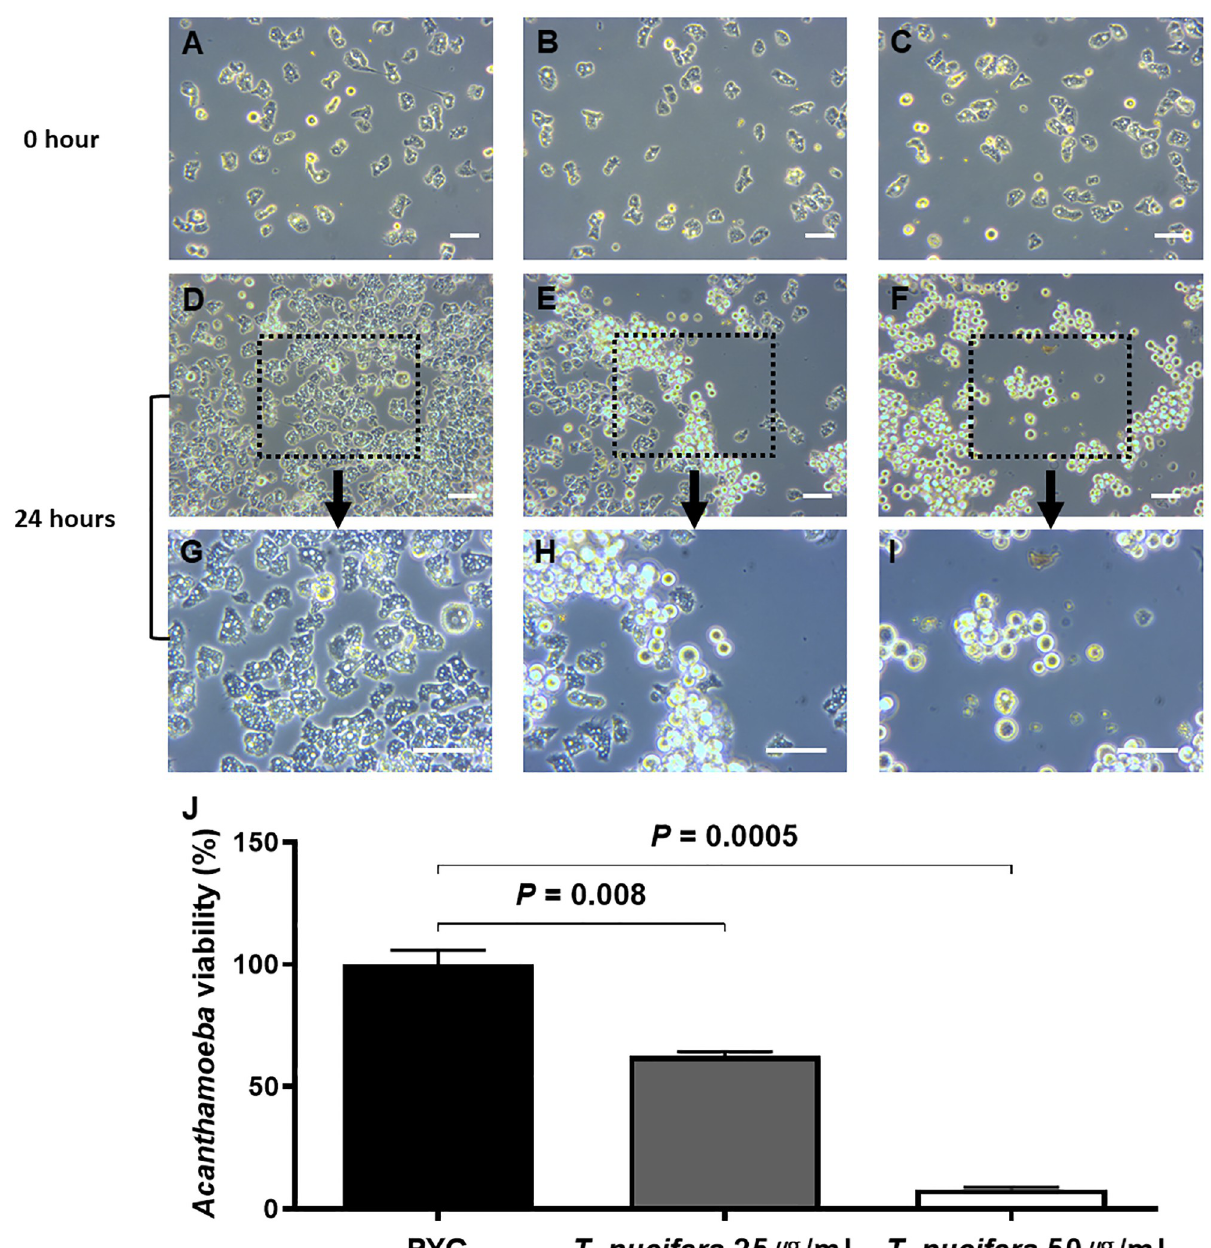
Fig 1. Morphological changes and cell viability in A . lugdunensis after 24 hours of treatment with Torreya nucifera . Compared with the control group (A, D, G), groups treated with 25 μ g/mL (B, E, H) and 50 μ g/mL (C, F, I) of T . nucifera showed morphological changes in which encystation from trophozoites to cysts and shrunken and unviable cells were observed. Cell viability was significantly decreased in the T . nucifera treated group and was dose-dependent (J). The scale bar represents 50 μ m..